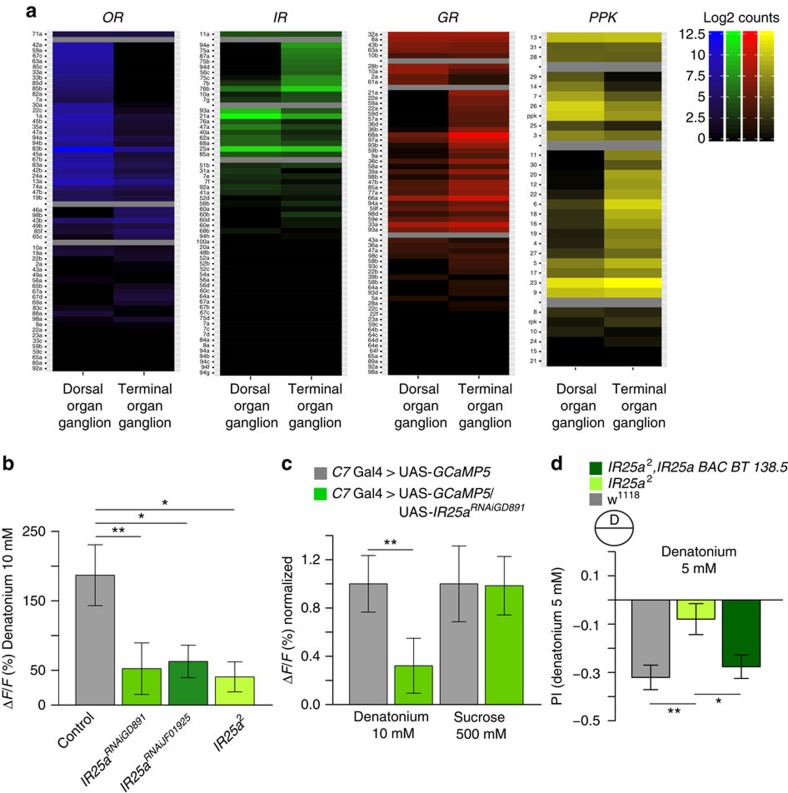
IR25a mediates the response to denatonium but not to sucrose in C7.(a) Illumina sequencing of RNA extracted by either the DOG or the TOG show regulation of olfactory receptors, IRs, GRs and PPKs. Heatmaps show the log2-transformed mean expression values. The genes in each heat map are classified according to their expression level into four classes and are separated by grey horizontal lines. The classes from top are: expression in both organs with log2-fold change (FC<1.5), higher or only expressed in DOG (FC>1.5), higher or only expressed in TOG (FC>1.5), low or no expression in either organ (read count<10). Detailed expression data is included in Supplementary Data 1. (b) Expression of IR25aRNAi in the C7 neuron reduces the ΔF/F (%) to denatonium (10 mM) significantly (IR25aRNAiGD891: P=0.004 and IR25aRNAiJF01925: P=0.03) with two different RNAi Lines or in the IR25a2 mutant background (c) but has no influence on the sucrose response (P=0.797). (d) The IR25a2 mutant shows significant problems to discriminate between neutral agarose and denatonium this phenotype can be restored by a rescue construct BAC138.5 (n=15–17). Error bars show the s.e.m. and significances are indicated as following: **P<0.01 and *P<0.05 in Wilcox rank sum test for individual groups and Wilcox signed rank test between two groups.